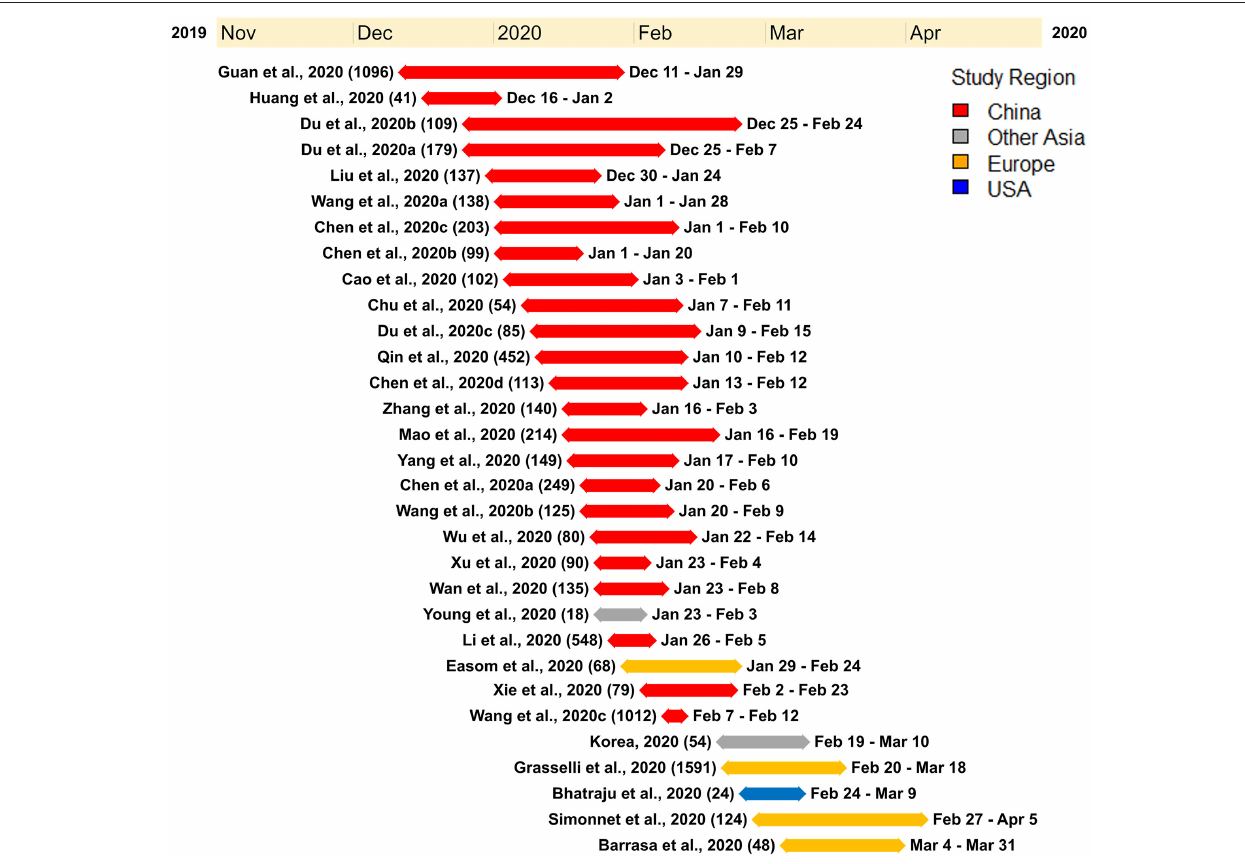
FIGURE 3 | Timeline illustrating the study period of each of the research studies used for the meta-analysis. Each research study used for the meta-analysis is represented by the study name (study sample), duration of the study with a line corresponding to the length of the study, and the start and end date of the study. The studies were ordered according to the start date of each